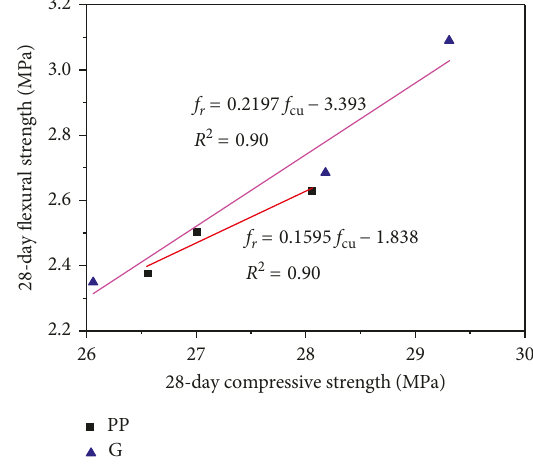
Figure 10: Relationship between the compressive strength and flexural